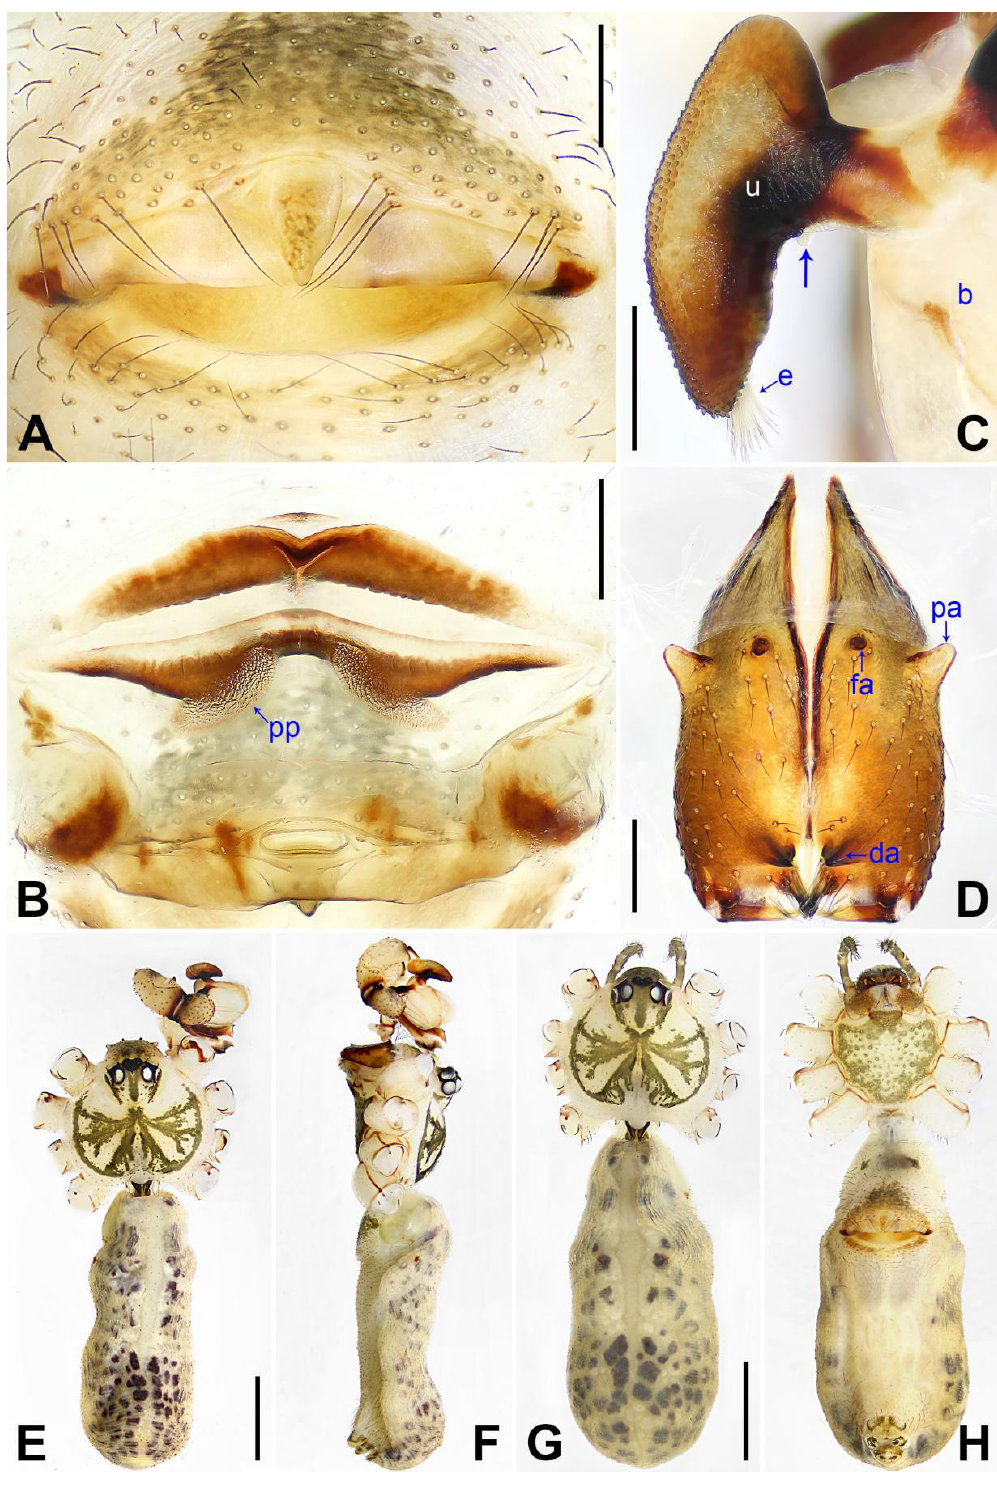
Figure 16. Pholcus xuanzhong sp. nov., holotype male ( C – F ) and paratype female ( A , B , G , H ): ( A ) epigyne, ventral view; ( B ) vulva, dorsal view; ( C ) bulbal apophyses, prolateral view (arrow points at ‘pseudo-appendix’); ( D ) chelicerae, frontal view; ( E ), ( G ) habitus, dorsal view; ( F ) habitus, lateral view; ( H ) habitus, ventral view. da = distal apophysis, e = embolus, fa = frontal apophysis, pa = proximo–lateral apophysis, pp = pore plate, u = uncus. Scale bars: ( A – D ) = 0.20 mm; ( E – H ) = 1.00 mm.